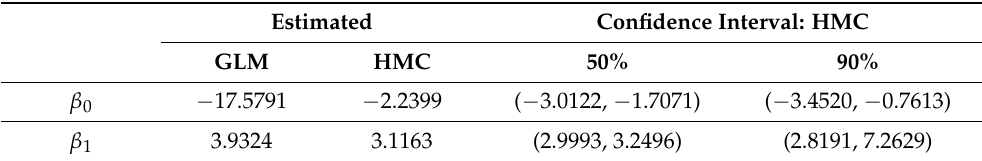
Table 5. Estimated parameters and intervals: car data set.